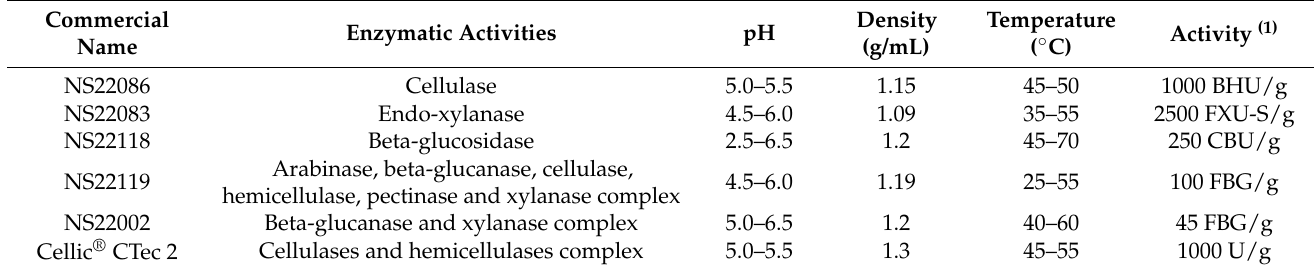
Table 1. Commercial carbohydrolase complexes employed in this